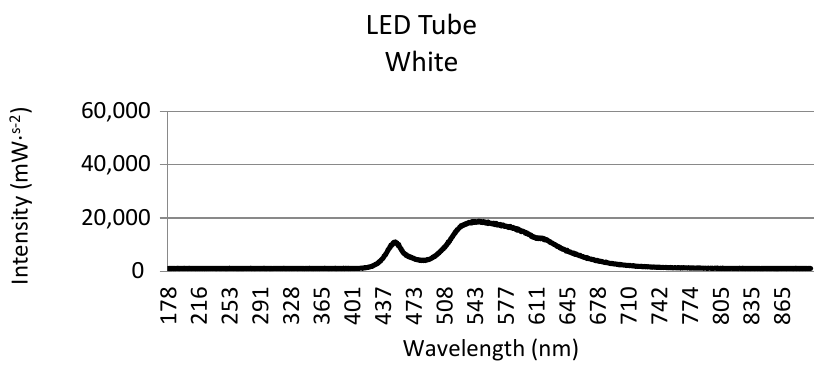
Figure 2. Spectral characteristic of white light.